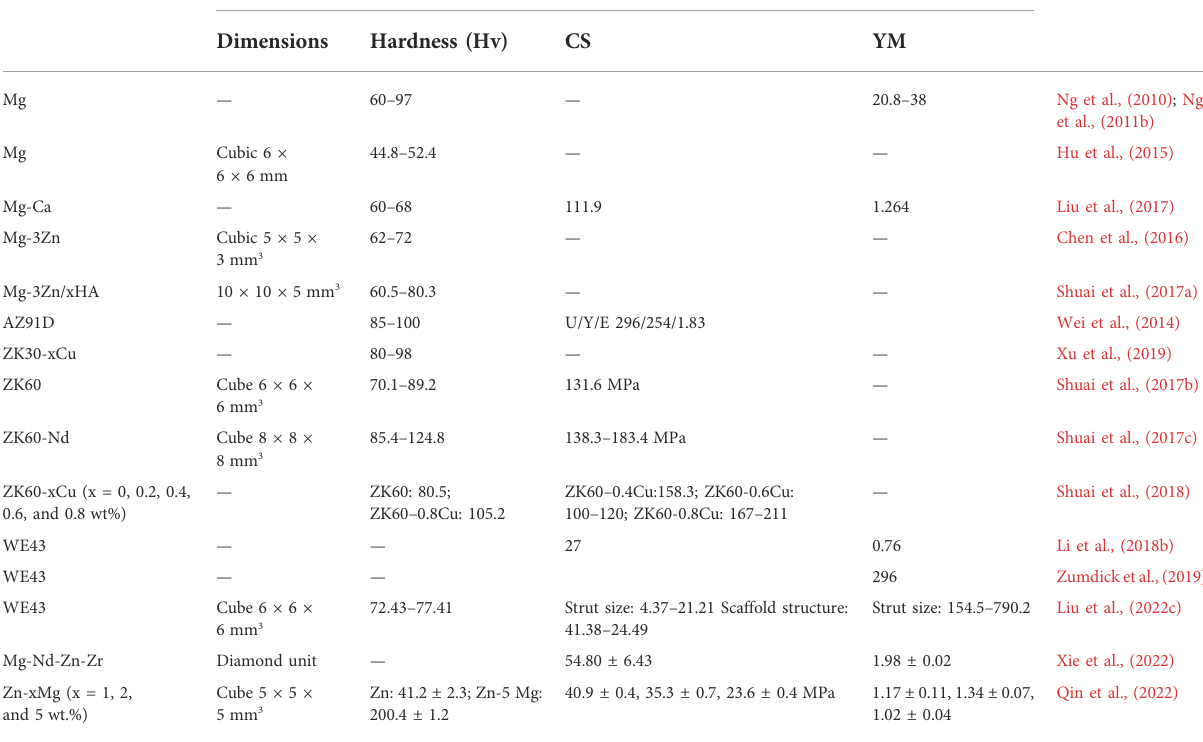
TABLE 3 Biomechanical properties of AM biodegradable